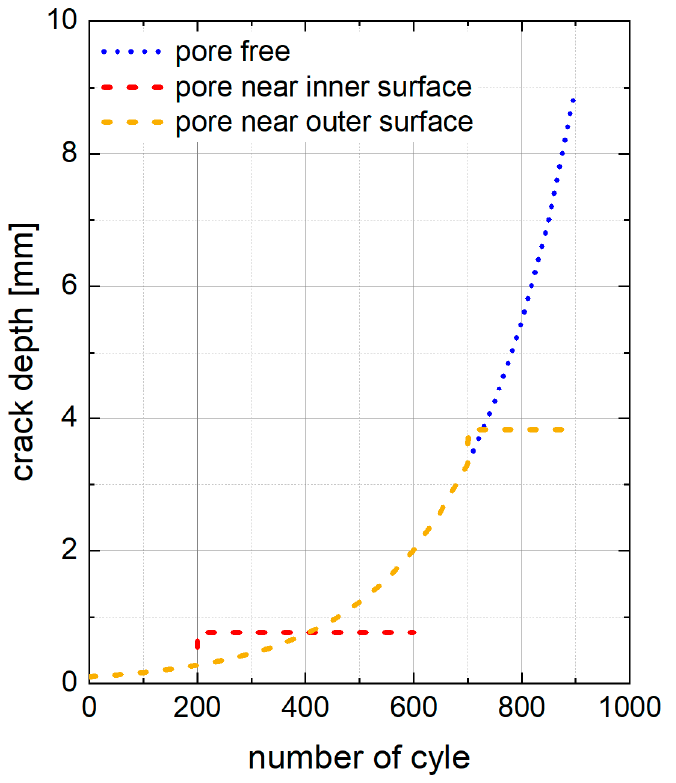
Figure 4. Working hypothesis for crack growth in structures with pores [20].